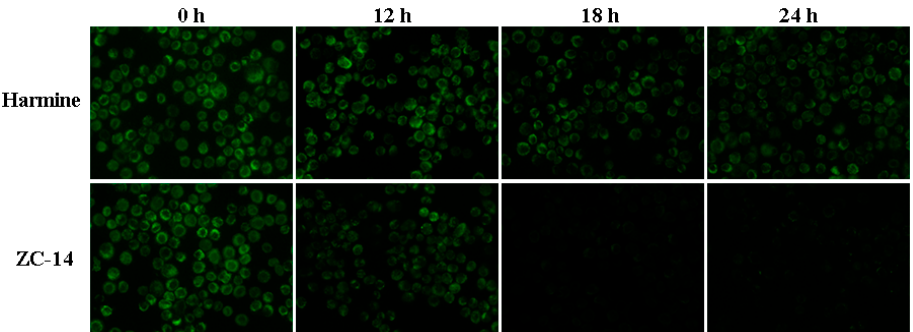
Figure 8. Mitochondrial membrane potential (MMP) changes of Sf9 cells were detected by Rhodamine 123 staining. The cells were incubated with 7.5 μ g/mL harmine and ZC-14 for 12, 18 and 24 h, respectively. The treated cells on glass coverslips were stained and the fluorescence of rhodamine 123 with green color was observed by fluorescence microscopy (20×).